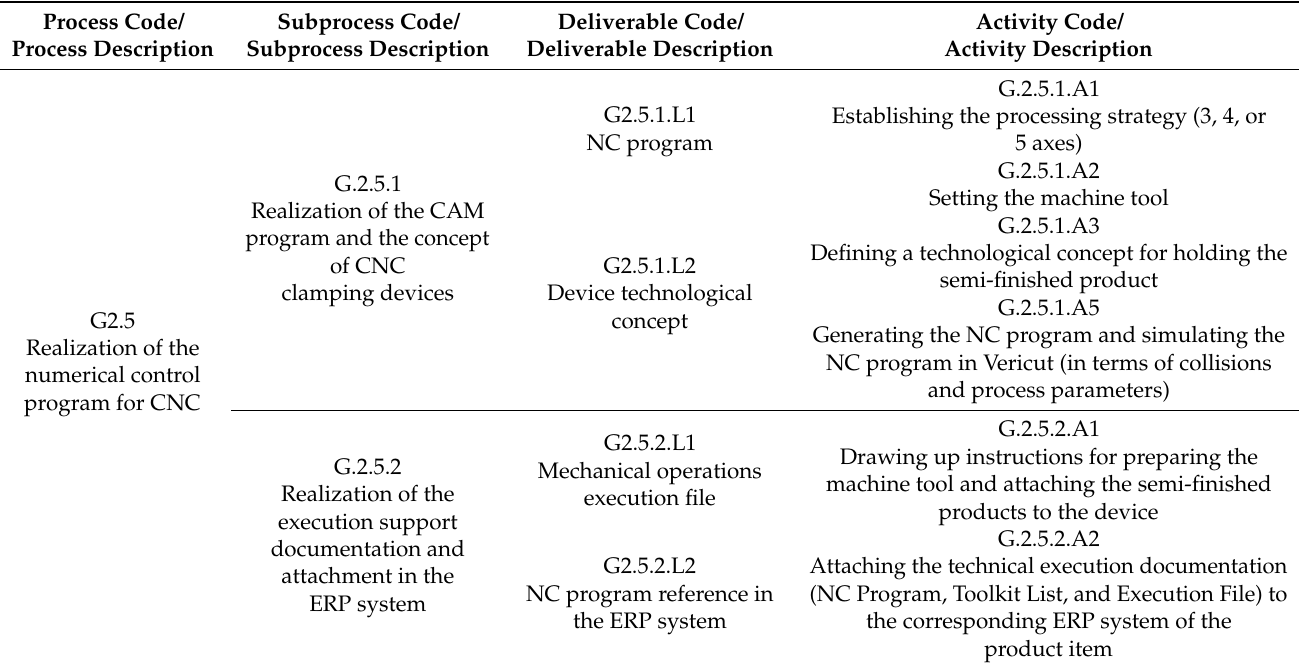
Table 3. Description of process group activities G2.5 and